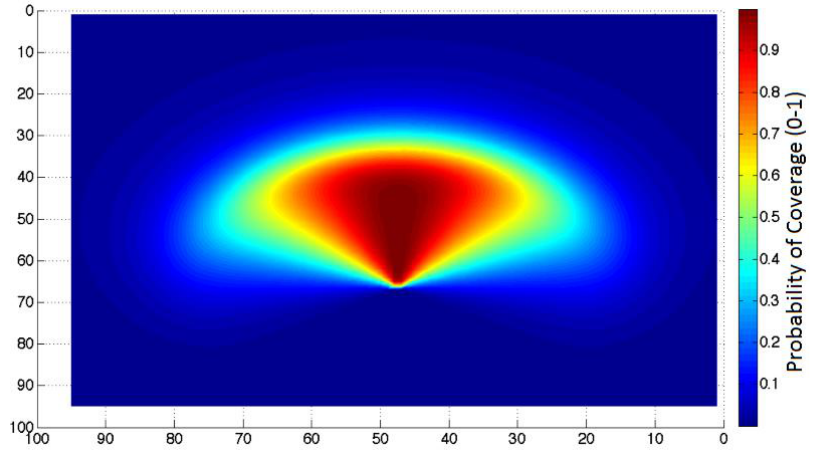
Figure 6. The probability measurement model of a sensor with limited distance range and angle [24].